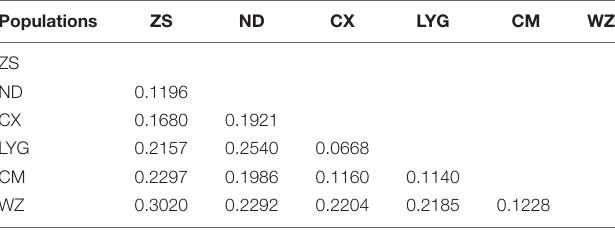
TABLE 5 | Nie’s unbiased genetic distance of six populations of rainbow clams.